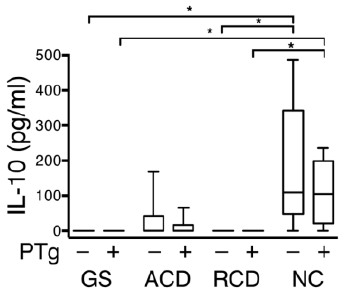
Figure 3. Comparison between groups of IL-10 secretion from the basolateral side of biopsy explants after 120 min, with and without PT-gliadin exposure. Media collected from the basolateral sides of explants obtained from non-celiac patients with gluten sensitivity (GS), celiac patients with active disease (ACD), celiac patients in remission (RCD), and non-celiac controls (NC). The NC group showed concentrations of IL-10 significantly higher than the corresponding media from the GS and RCD group. In the graphs, the box defines the 25th and 75th percentile; center line the median; whiskers the range. * p <